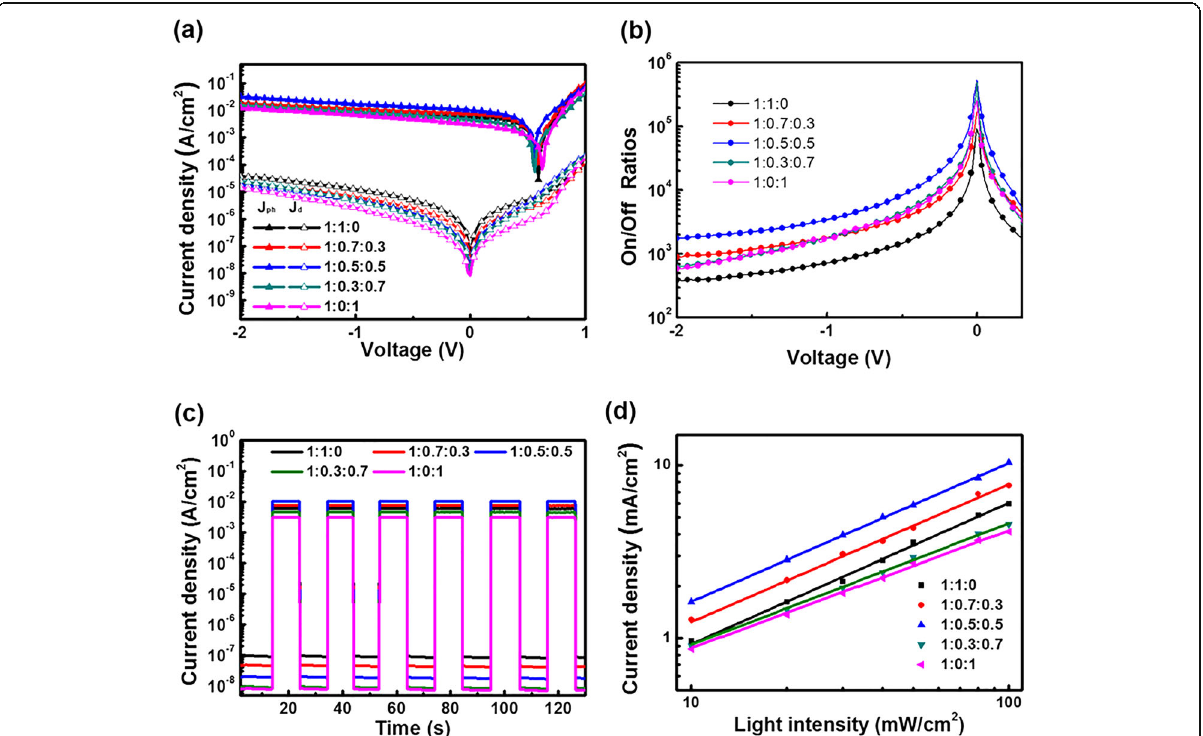
Fig. 5 a J - V characteristics of OPDs with various ratios under dark and light conditions. b On/off ratios of OPDs. c Response/recovery characteristics of the OPDs under light on/off modulation. d J SC of OPDs as a function of light